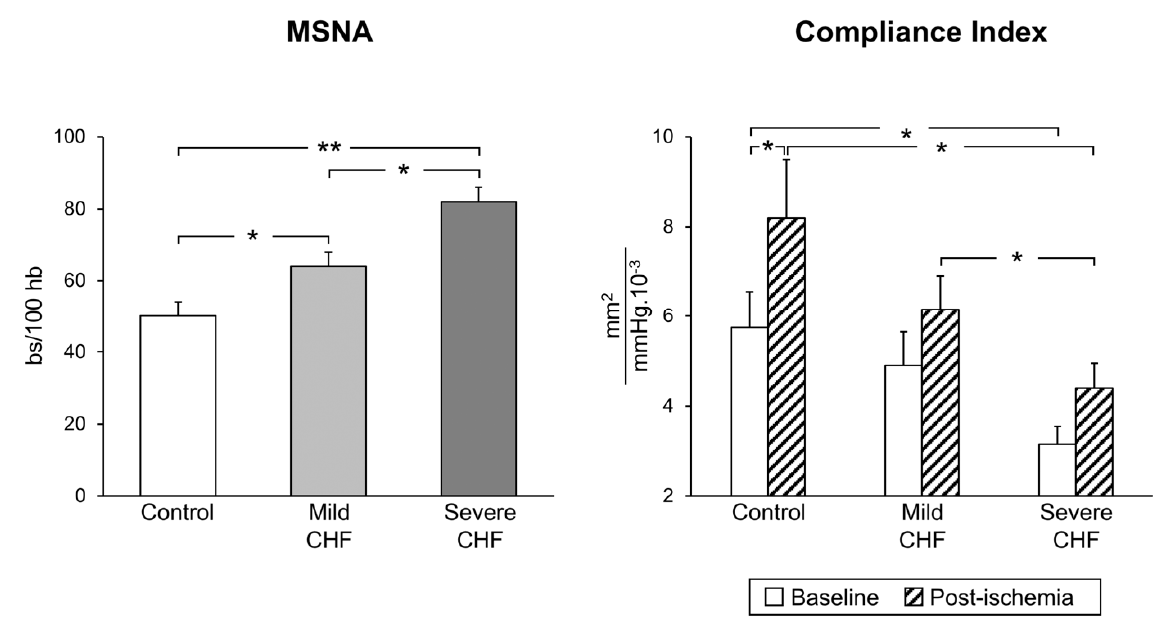
Figure 2. Progressive increase in sympathetic nerve traffic (left panel, MSNA, as assessed via microneurography) and progressive decrease in arterial distensibility (compliance index, right panel) from the healthy state (control subjects) to patients with mild and severe congestive heart failure (CHF). Bs: bursts; HB: heart beats. Asterisks (* p < 0.05, ** p < 0.01) refer to the statistical significance between groups. From data presented in Ref. [6].